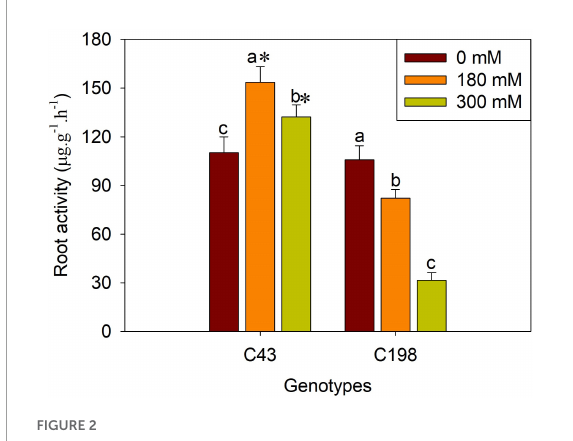
FIGURE2 Effects of salt stress on root activity in the two bermudagrass genotypes (C43, tolerant; C198, sensitive). Bars marked by the same letters are not significant at P < 0.05 (Tukey’s test) for the comparison of different salt concentrations within a given genotype. Bars marked with star (*) indicate significance at P < 0.05 (Tukey’s test) between the two genotypes at a given salt concentration. Data represent the mean ± SD of four independent biological replicates.